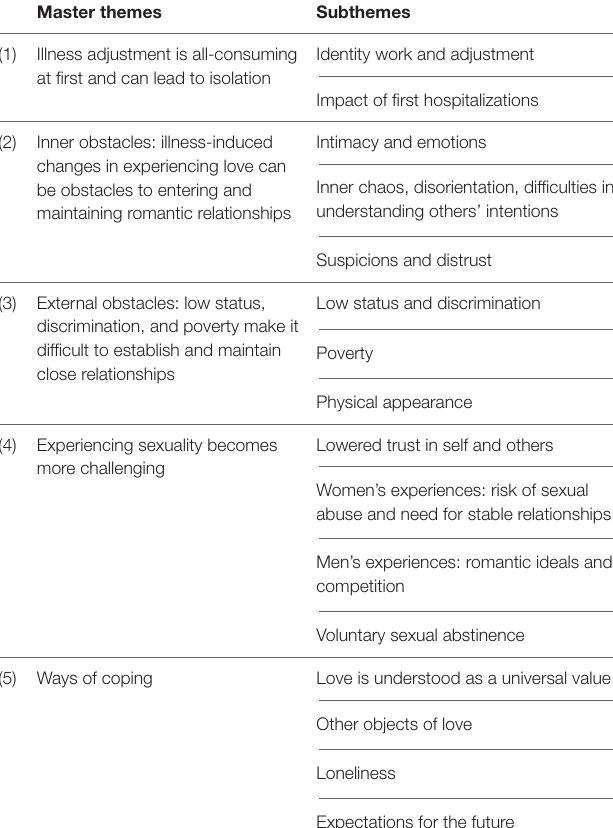
TABLE 1 | Master themes and subthemes in